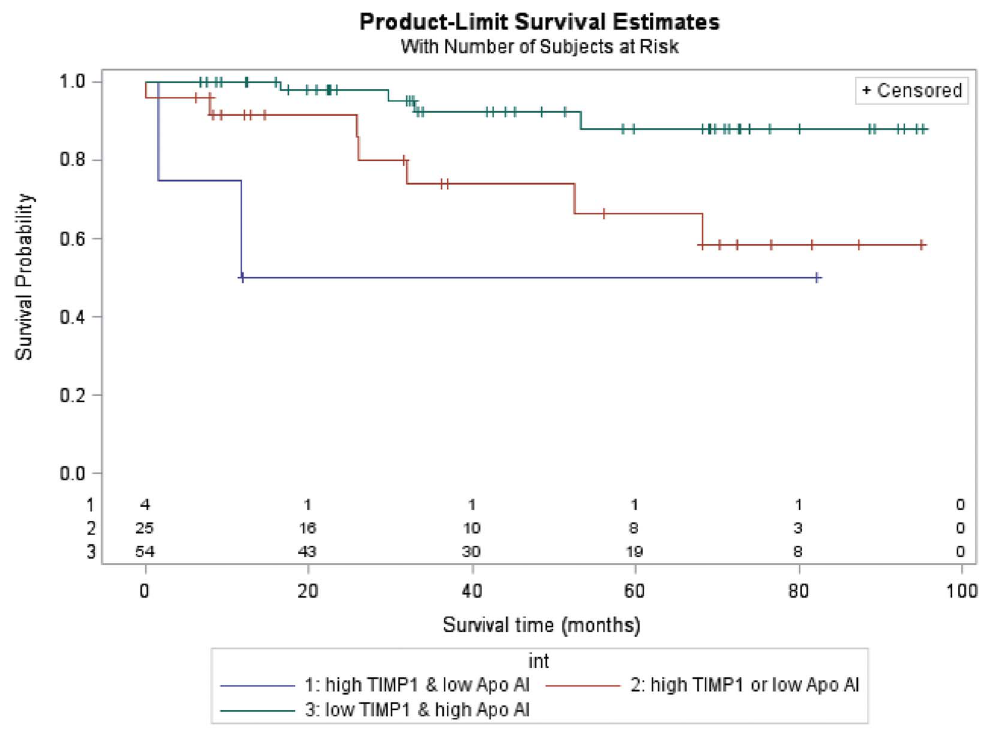
Figure 4. Survival curves comparing patients stratified by TIMP-1 and apolipoprotein-AI values. Patients with high TIMP-1 and low apolipoprotein-AI values (red) had lower survival (log-rank test p-value , 0.01). The number of subjects at-risk are displayed along the x-axis.